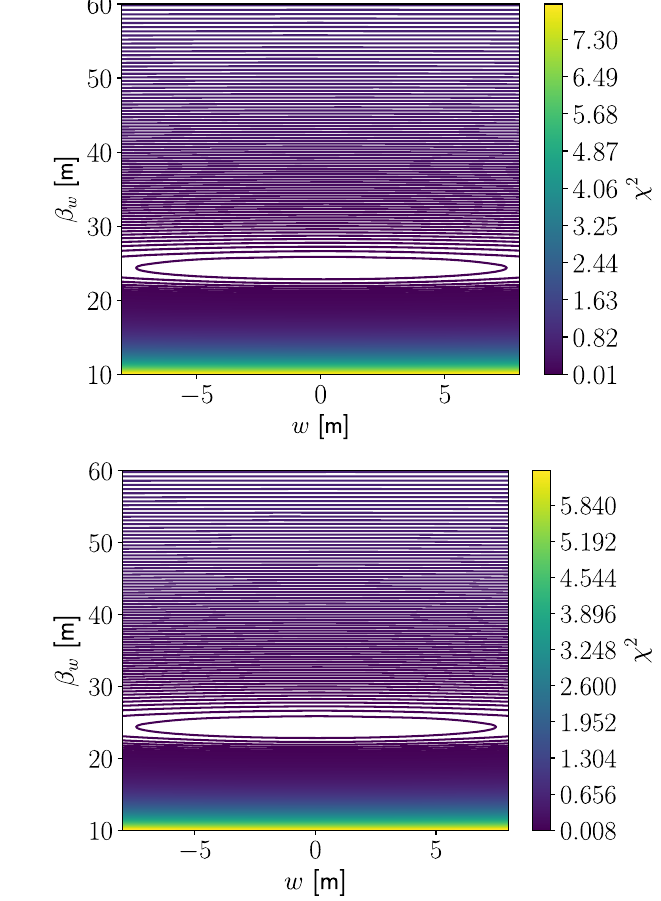
FIG. 11. Example of the optimization algorithm for low- β (cid:1) for Ω ¼ 0 (top) and Ω ¼ 0 . 2 (bottom). Regardless of the value of the weight, Ω will always converge the right